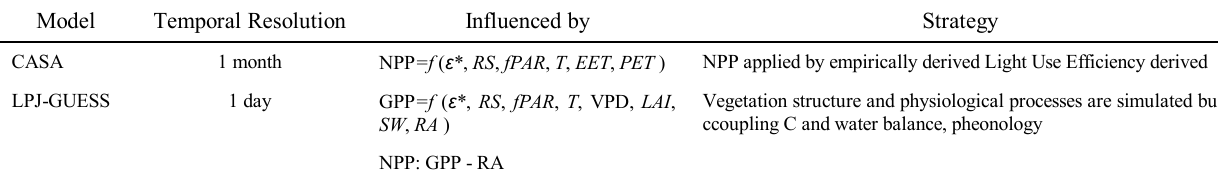
Table 1. Comparison of the broad features of the CASA and LPJ Models